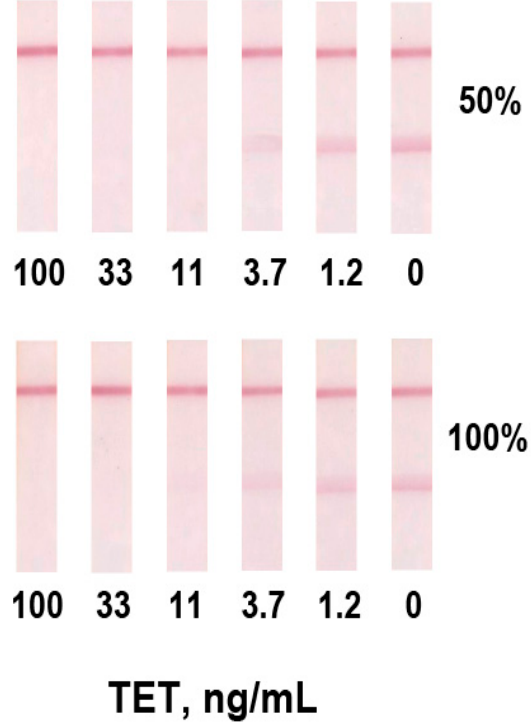
Figure 3. Images of immunochromatographic assay (ICA) test strips with indirect antibody labeling after analysis of serum samples. The strips are arranged according to the tetracycline concentration.